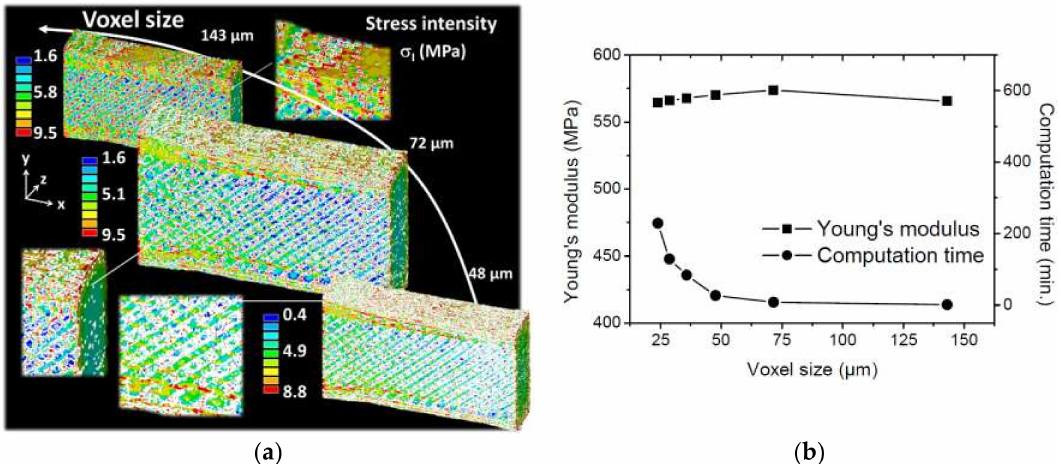
Figure 11. ( a ) Prediction of the stress intensity distribution in 3D printed Wood-PLA / PHA using finite element computation as a function of the voxel size. ( b ) Influence of the resolution on the predicted Young’s modulus of wood-PLA / PHA printed at 230 ◦ C. The computation time trend is also